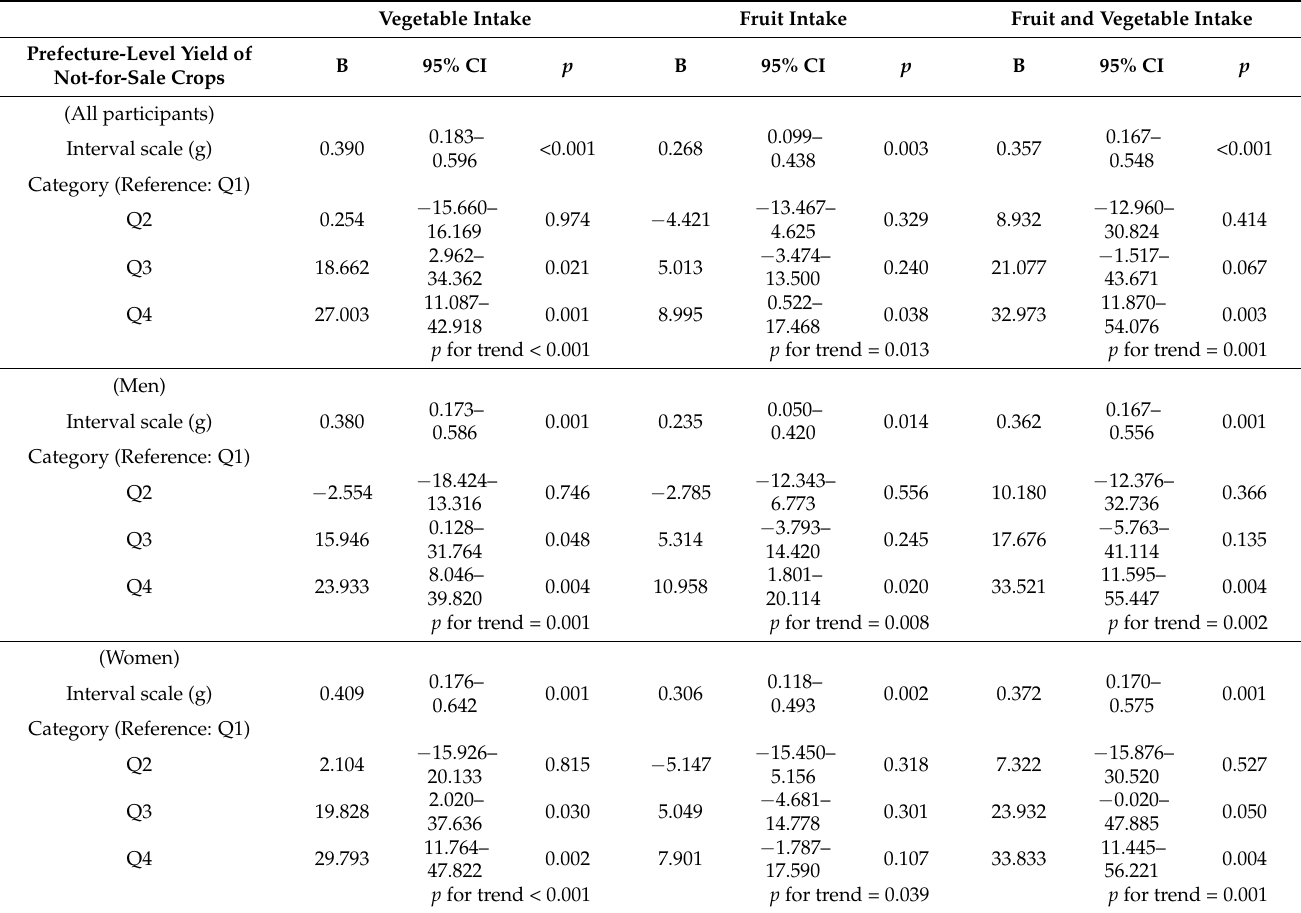
Table 4. Relationship between prefecture-level yield of not-for-sale fruits and vegetables and individual-level fruit and vegetable intake. Vegetable Intake Fruit Intake Fruit and Vegetable